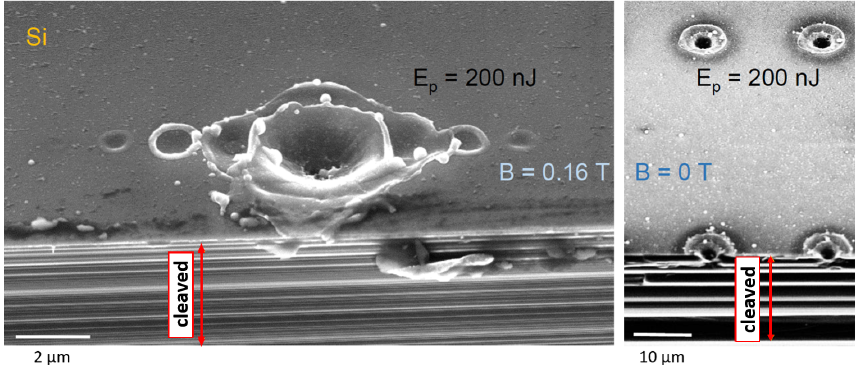
Figure A1. 45 ◦ Slanted-view SEM image of the ablation sites made by E p = 200 nJ energy single pulse (objective lens NA = 0.7, T = 0.22) with magnetic field and without. The linear pattern of micro-ablation pits is aligned with the B-field direction.